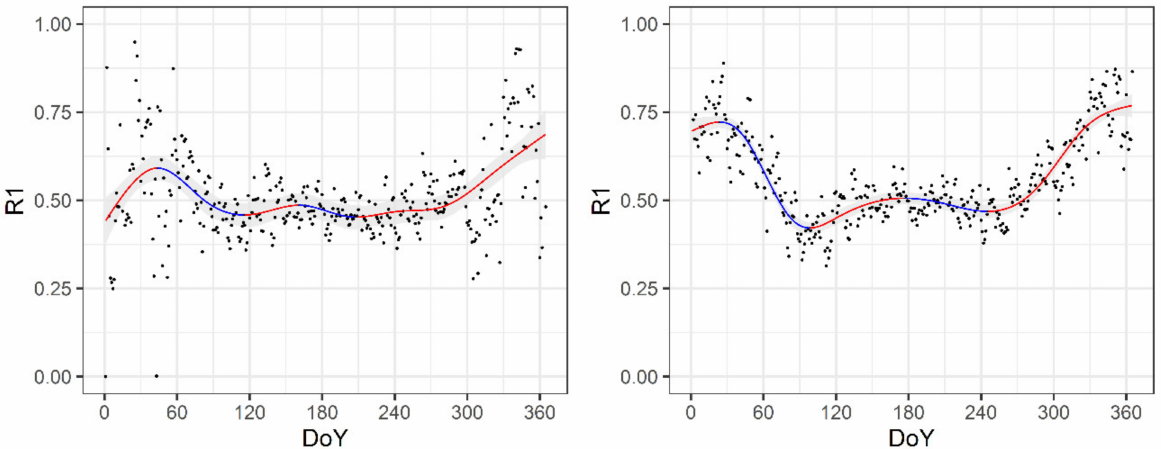
Figure 12. Seasonal variation of R 1 in apple orchard (NS/CE; ( left )) and winter wheat/sugar beet canopy (NS/TE; ( right